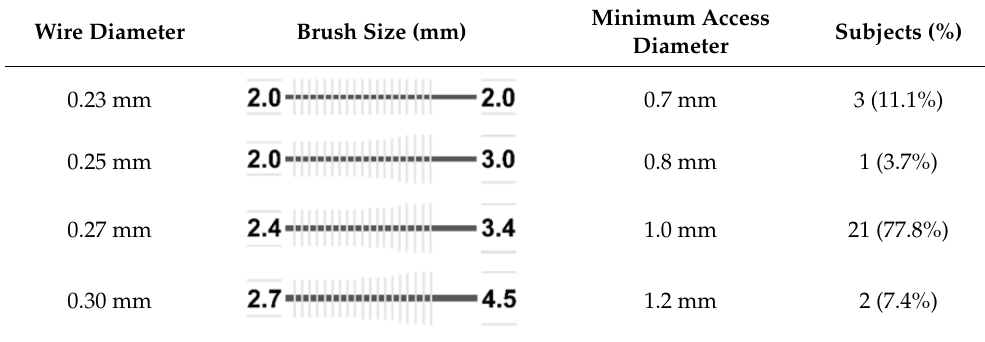
Table 1. Information about the size of the interdental brush.